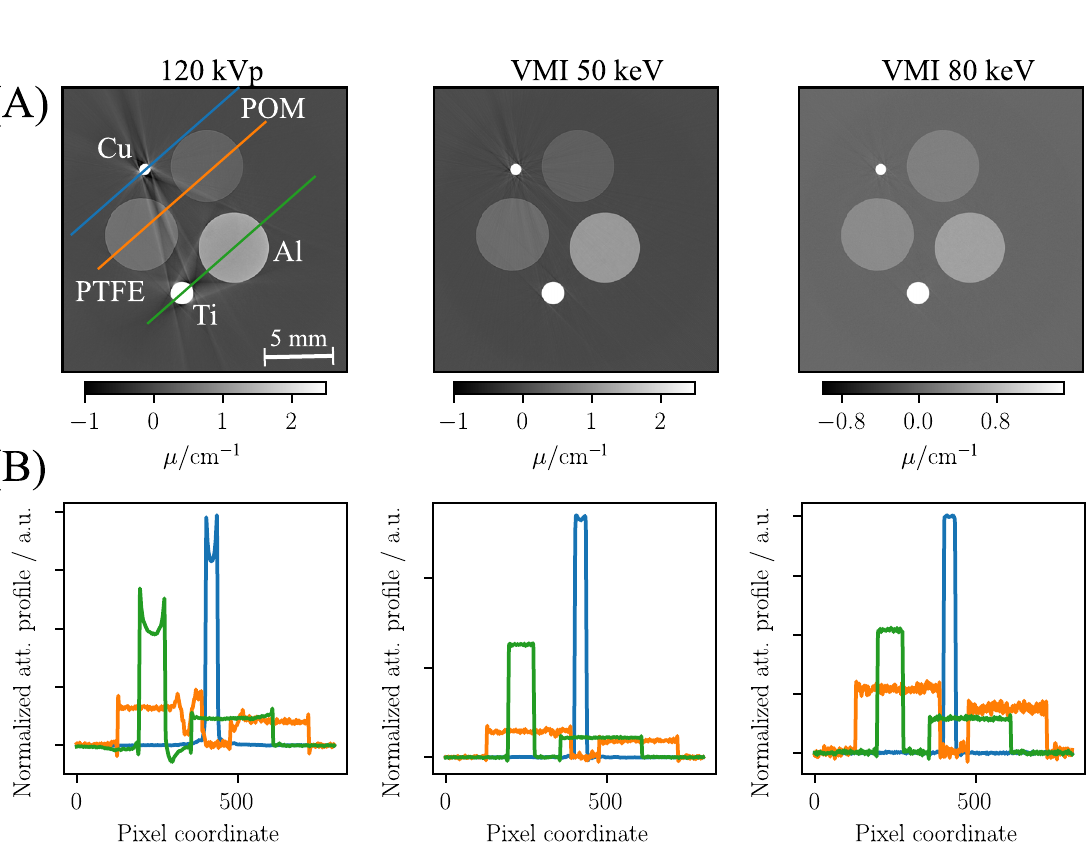
Fig 5. Spectral CT images of the phantom used to assess the capability of correcting beam-hardening. The upper row (A) shows the reconstructed image data after a copper wire was added to the phantom. The influence of the strongly attenuating copper wire was analyzed by line-plots (B). The depicted images correspond to the mean of 10 slices of the reconstructed image volume to improve the visual appearance of potential artifacts.